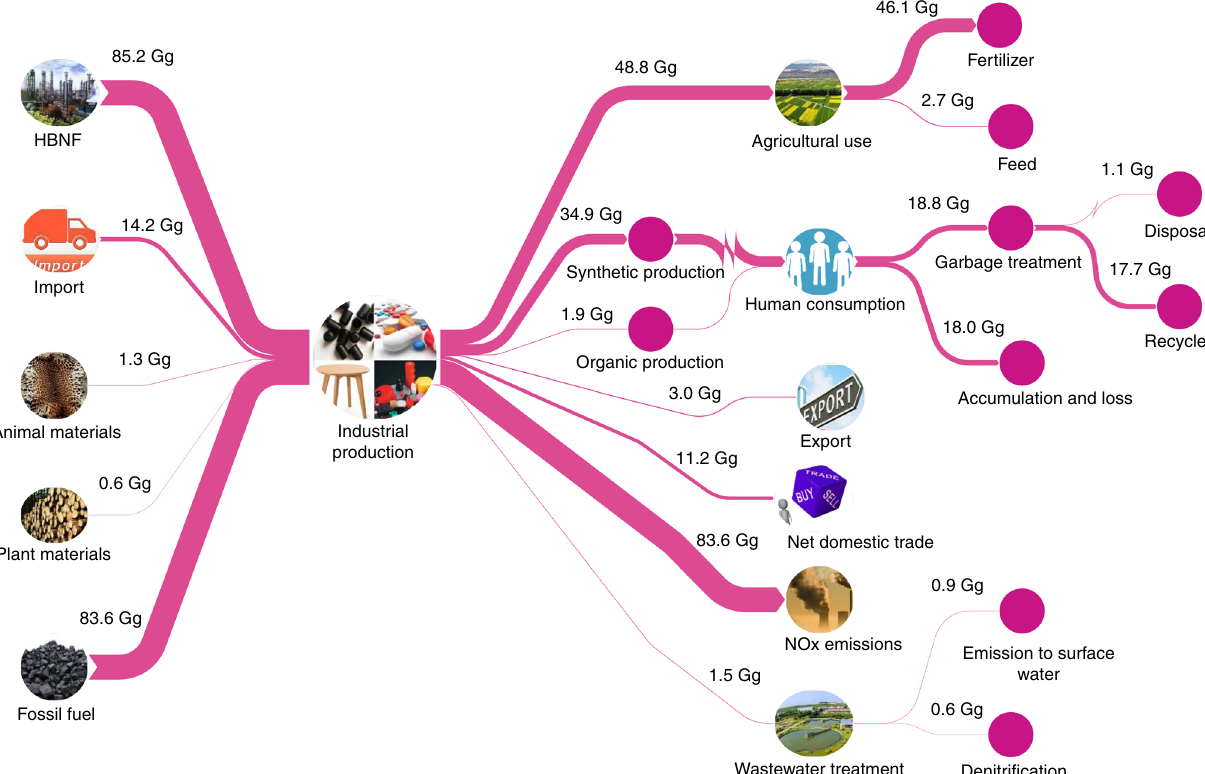
Fig. 3 Life cycle analysis of the industrial Nr fate of Guangzhou in 2015. Anthropogenic inputs of Nr through HBNF, import, agriculture materials and fossil fuel provide industrial products (including synthetic and organic products) to meet human demands, a fraction of Nr is for agriculture use and human consumption, the rest is transferred outside the system or lost to the environment. HBNF, Haber-Bosch N fi xation. Units are in Gg N y − 1 .